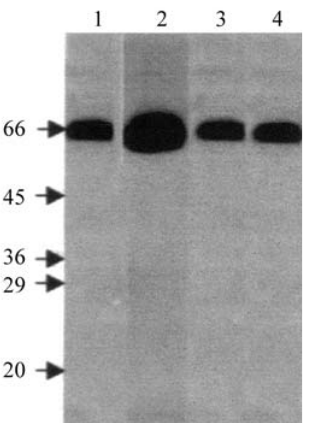
Figure 7 - Electrophoretic separation of G4, Mutant Metl, Mutant Met2,3 and Mutant Metl,2,3 synthesized in vitro. Lane 1: G4 synthesized protein using plasmid pSP65/248 ; Lane 2: Metl synthesized protein using plasmid pSP65/248 Metl ; Lane 3: Met2,3 synthesized protein using plasmid pSP65/248 Met2,3 ; Lane 4: Metl,2,3 synthesized protein using plasmid pSP65/248 Metl,2,3 . Size of the protein markers is given in